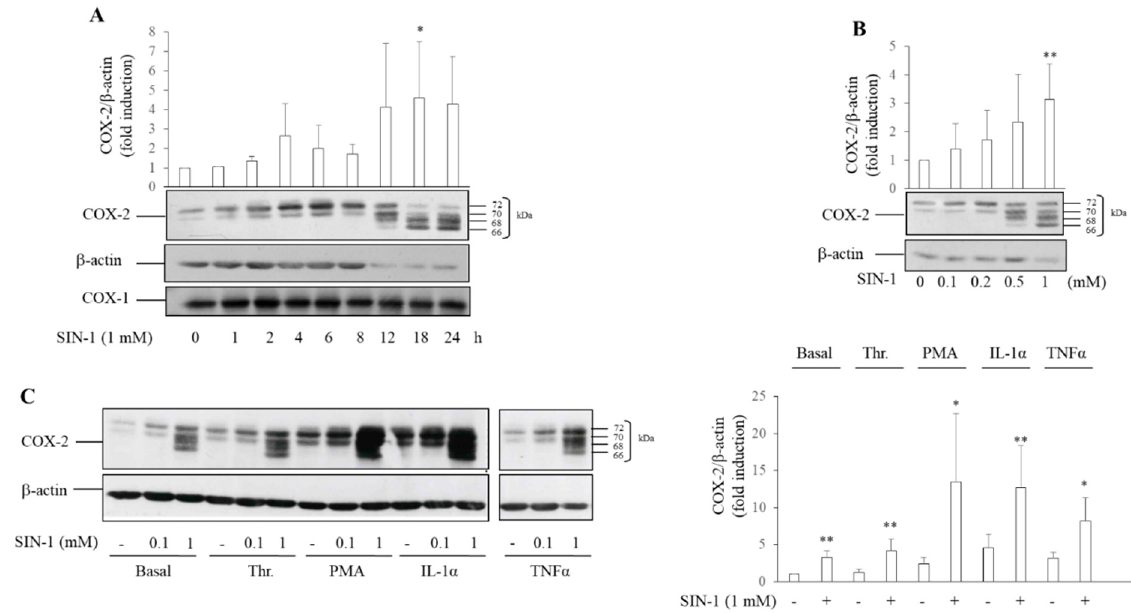
Figure 1. COX-2 expression induced by SIN-1. Human umbilical vein endothelial cells (HUVEC) were incubated with SIN-1 alone or in combination with stimuli such as thrombin (Thr), phorbol 12-myristate 13-acetate (PMA), TNF α , or IL-1 α , and the protein expression was evaluated by Western blot analysis. β -actin was used as a control of protein loading. Densitometry is shown in the bar graph. ( A ) Time-dependent expression of COX-2 and COX-1 induced after exposure to 1 mM SIN-1. Results are representative of 3–6 independent experiments; * p < 0.05 vs. control cells treated with vehicle ( B ) Concentration-dependent expression of COX-2 induced by SIN-1 after 18 h incubation. Results are representative of 7 independent experiments; ** p < 0.01 vs. control cells ( C ) COX-2 protein levels in HUVEC exposed to 0.1 and 1 mM SIN-1 alone or in combination with 0.5 U/mL Thr, 5 nM PMA, 100 U/mL TNF α , or 25 U/mL IL-1 α . The lanes for TNF α were run on a parallel gel. Results are representative of 5–9 independent experiments. * p < 0.05, ** p < 0.01 vs. respective cells incubated in the absence of SIN-1.